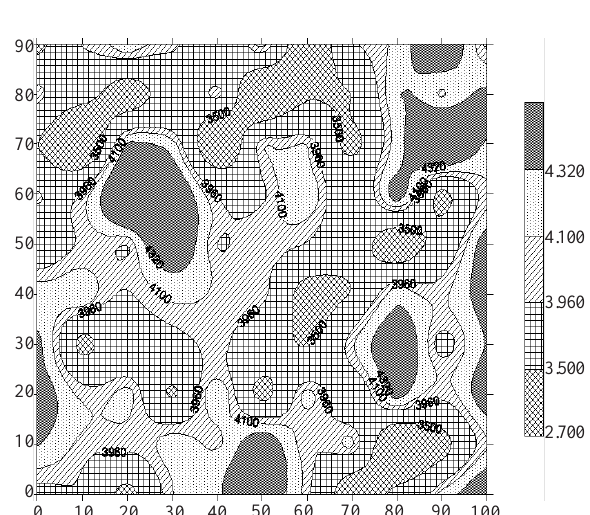
Figura 5. Mapa de produtividade de milho (M8) em kg ha -1 – Votuporanga,